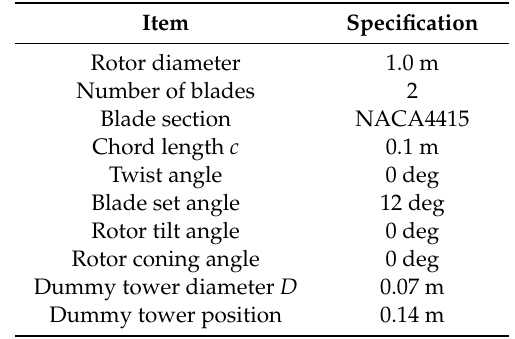
Figure 1. Outline of the wind tunnel test and model setup described in [24]. Table 2. Specifications of the wind tunnel test model described in [24].